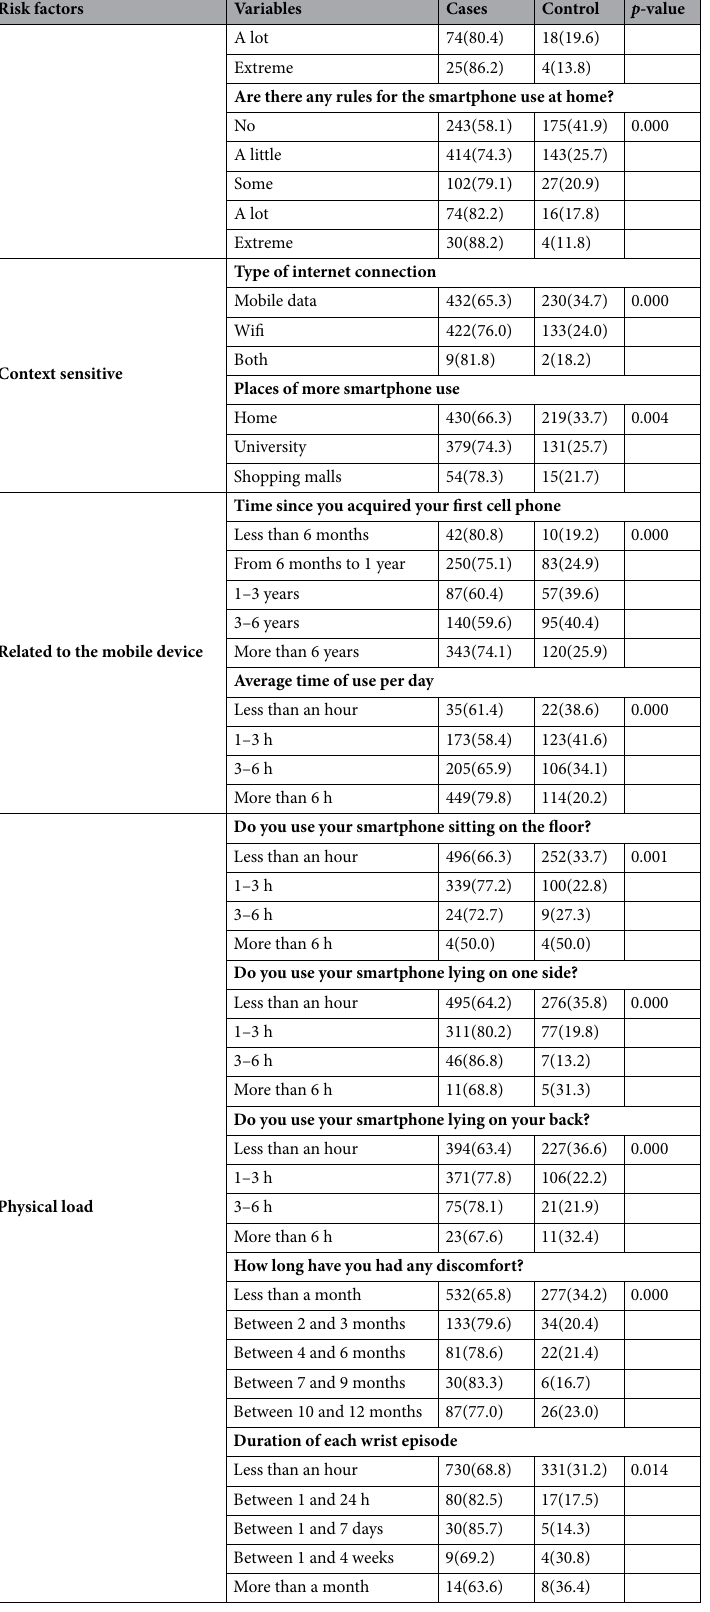
Table 1. Qualitative variables: university students with and without smartphone